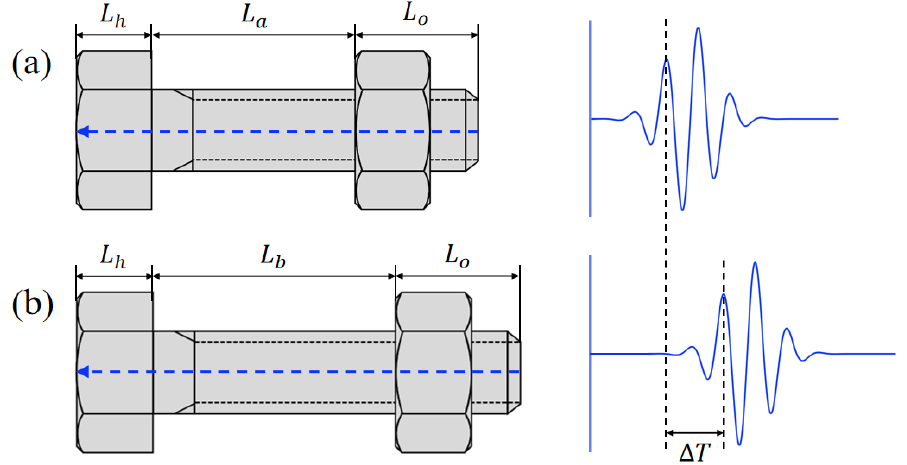
Figure 1. Fundamental principle to measure the bolt preload force by the mono-wave method: ( a ) TOF of the pulse − echo before tightening; ( b ) TOF of the pulse − echo after tightening.